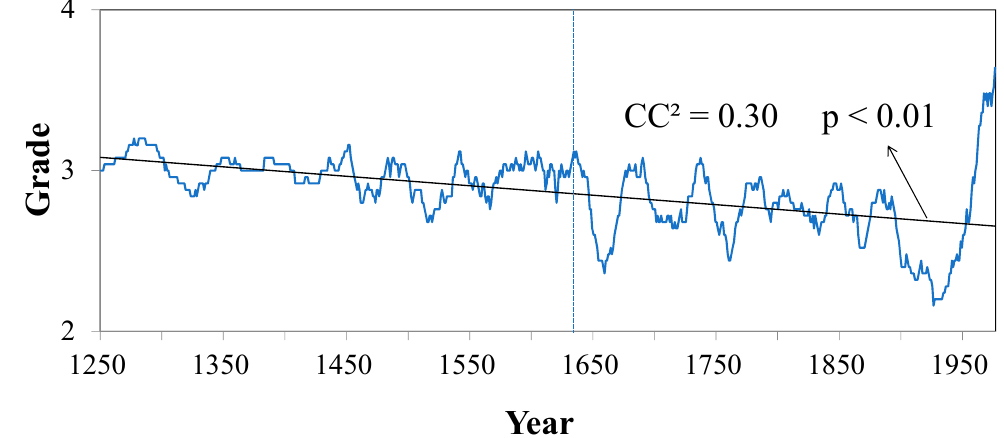
Figure 2. A 25-year moving average of drought and flood grades in Wuzhou City.